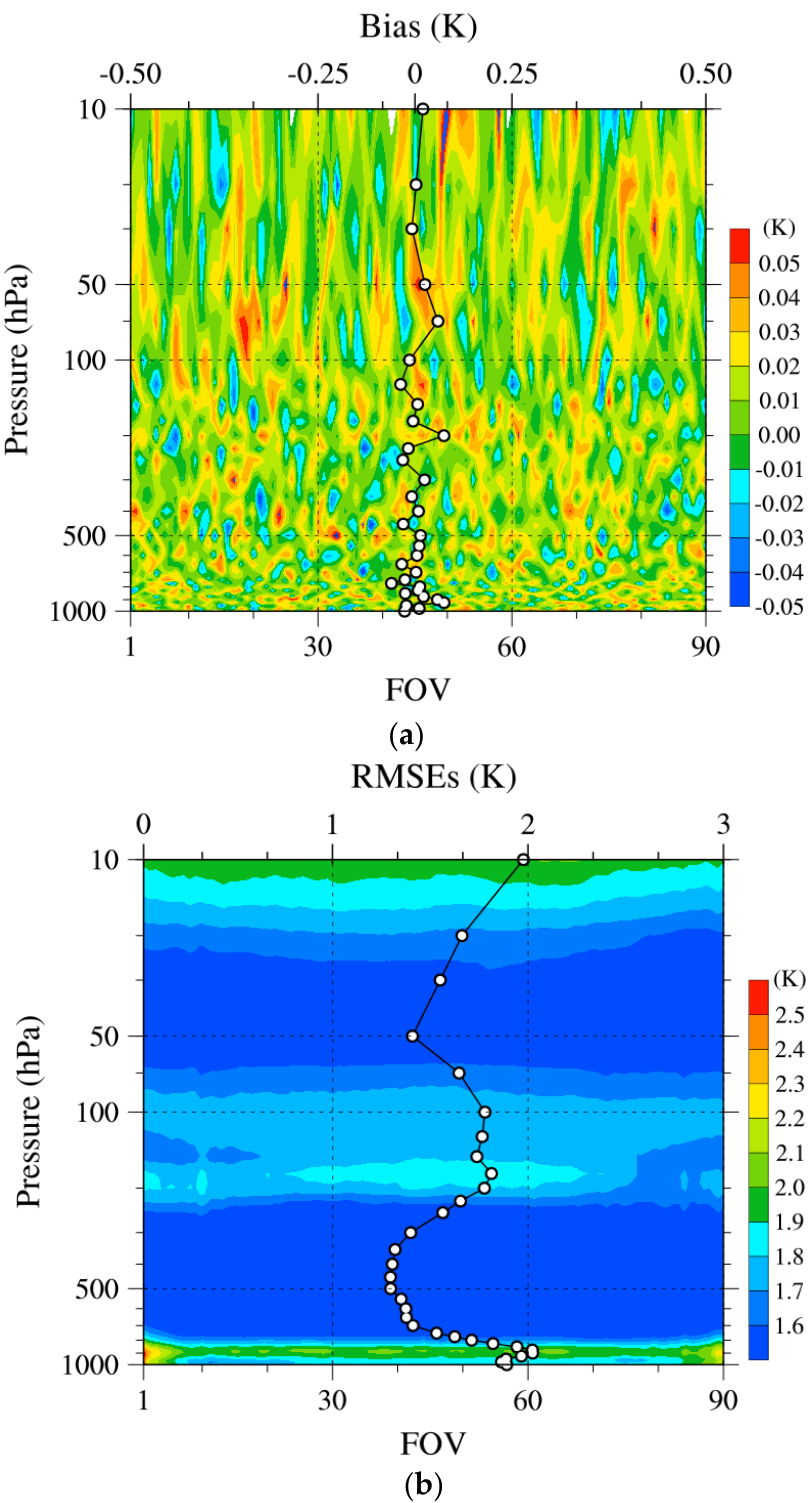
Figure 12. ( a ) Biases and ( b ) root-mean-square errors (RMSEs) of the temperatures between FY-3D MWTS-2 retrievals and the hourly ERA5 from 1 to 30 August 2019 at different FOVs. The vertical circles represent mean vertical biases and RMSEs in ( a , b ), respectively.